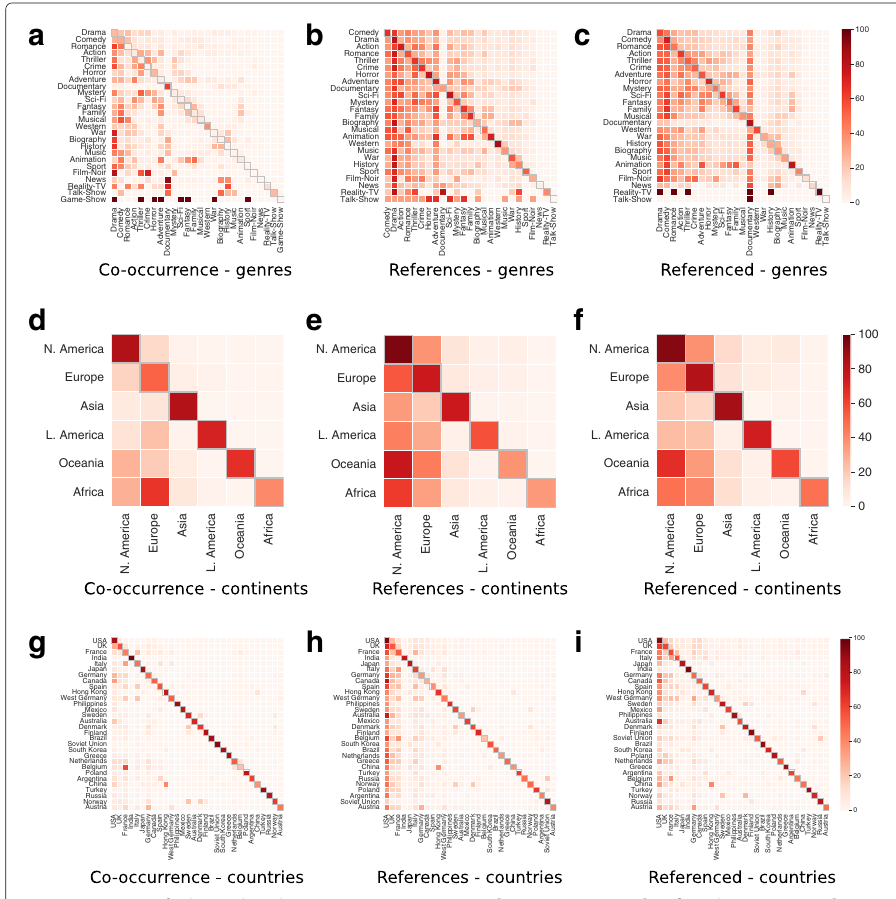
Fig. 2 Densities of relationships between tags in Genres ( a , b , c ), Continents ( d , e , f ) and Countries ( g , h , i ): ( a , d , g ) shows how much a tag is used with other ones, divided by total number of movies belonging to the first tag, using the diagonal for counting when a tag is used alone; ( b , e , h ) show how much a tag references the other ones, divided by total number of movies belonging to the tag that makes at least one reference; ( c , f , g ) show how much a tag is referenced by the other ones, divided by total number of movies belonging to the tag that receives at least one reference. Since a movie can be labeled with multiple tags in the same item, rows sum to values bigger than